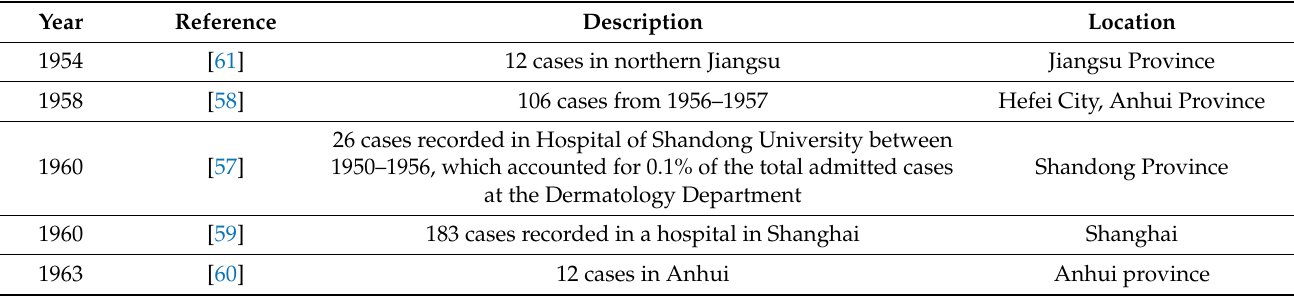
Table 1. Report of tinea imbricata in